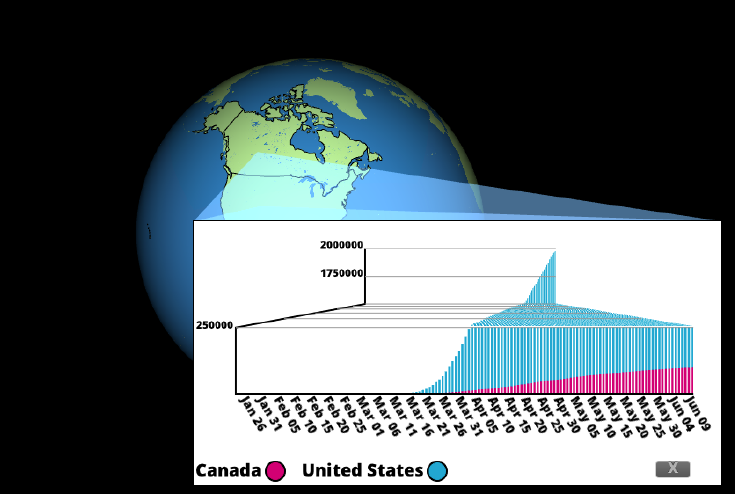
Figure 6. Multivariate charts can be represented using a stepped perspective chart for certain combina- tions of